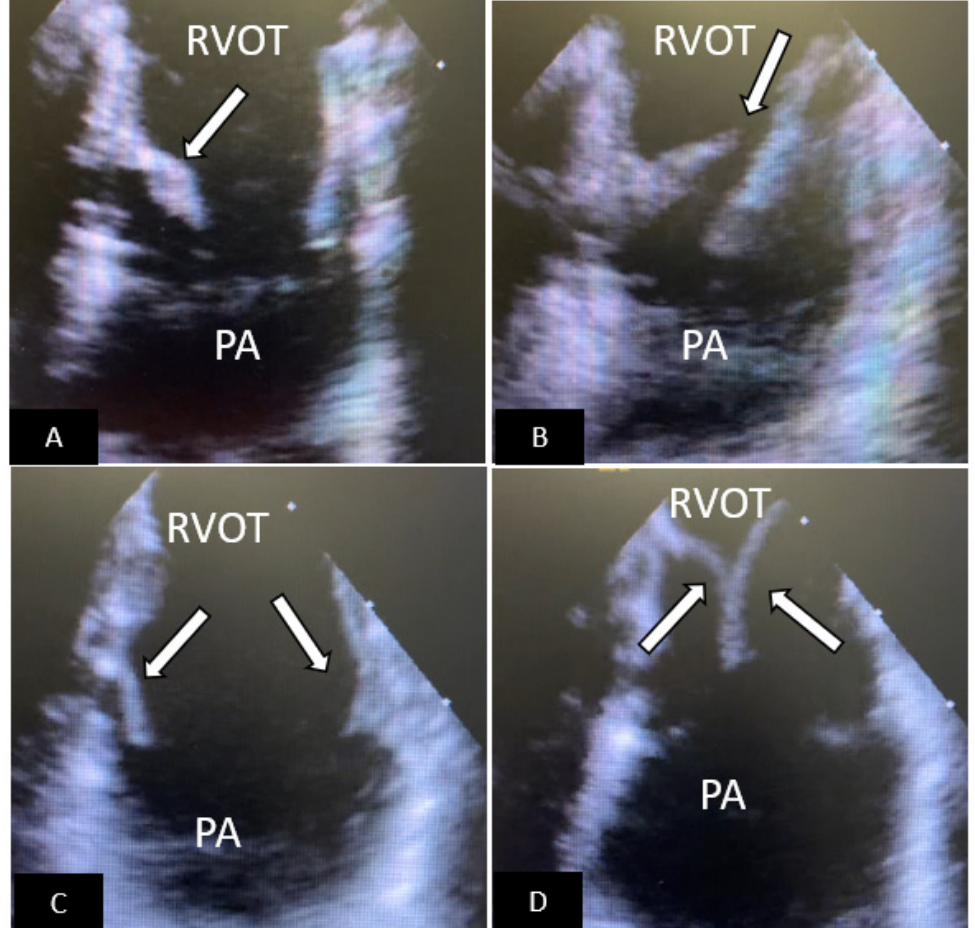
Figure 13. Intracardiac echocardiography (ICE) to assess for early failure of an Edwards-Sapien S3 TPV. The ICE probe is placed in the right ventricular outflow tract. ( A ) The TPV is seen in the open position. The medial leaflet (arrow) is shortened, thickened, and has limited systolic excursion. ( B ) When the TPV closes there is failure of coaptation of the leaflets (arrow) with resultant pulmonary regurgitation (not shown). ( C ) A new valve-in-valve Edwards-Sapien S3 was placed. ICE image now shows that the leaflets (arrows) are of the same length, thin, and show normal systolic excursion. ( D ) When the TPV closes the leaflets show excellent coaptation (arrow) and there is no pulmonary regurgitation (not shown). RVOT=right ventricular outflow tract, PA=pulmonary artery.